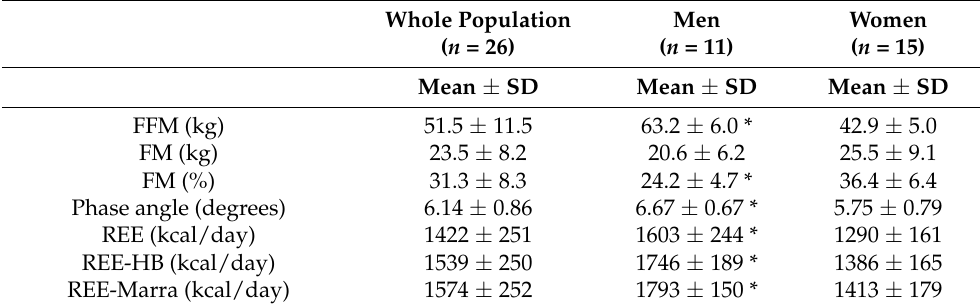
Table 2. Body composition and resting energy expenditure (measured and estimated) of the study